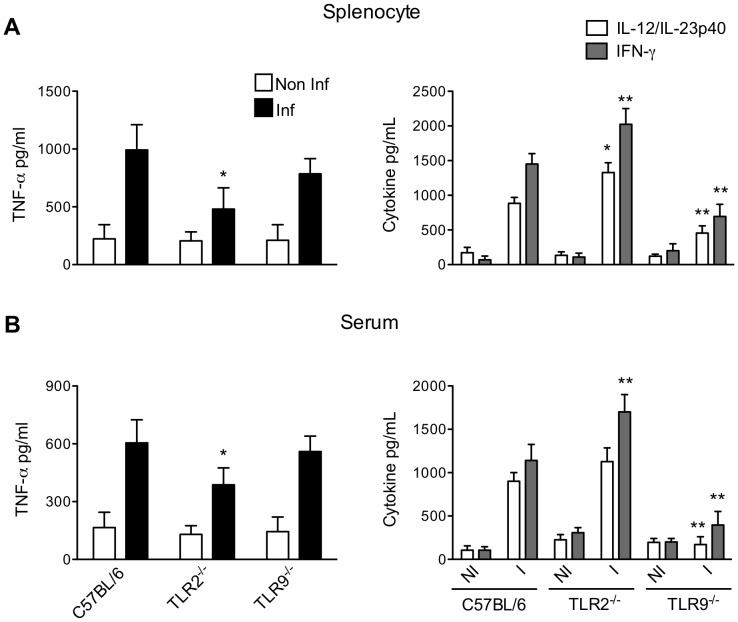
Comparison of the proinflammatory response in TLR2- and TLR9-deficient mice during the acute phase of T.cruzi infection.Cytokine levels in spleen cell culture (A) and serum (B) from either control (NI) or infected (I) C57BL/6 WT, TLR2−/−, TLR9−/− mice evaluated seven days post-infection. The data represent the mean of two experiments. *p<0.05 and **p<0.01 indicate statistical significance when comparing cytokine level in serum or in splenocyte culture from knockout versus C57BL/6 WT infected mice.